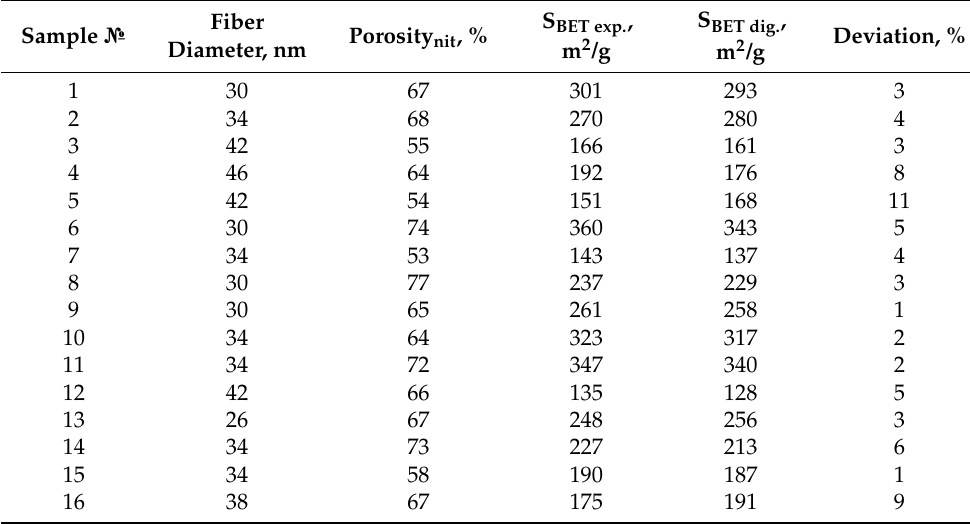
Table 3. Experimental and digital structures SSA